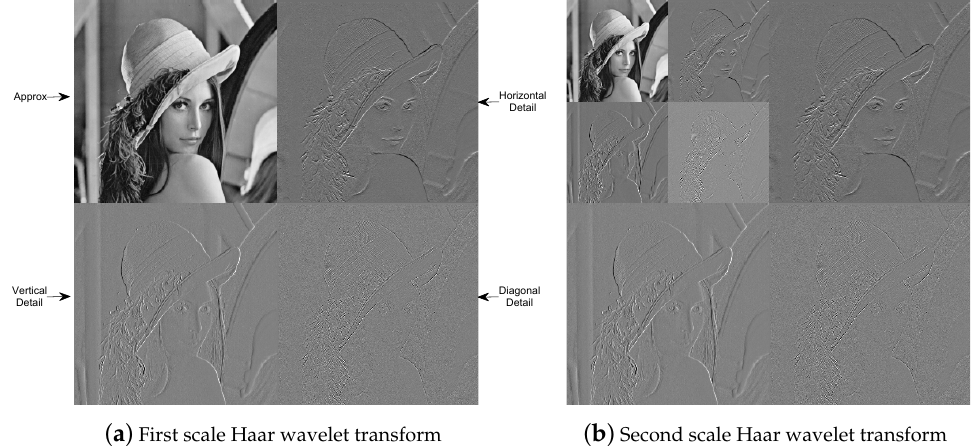
Figure 8. Haar Wavelet